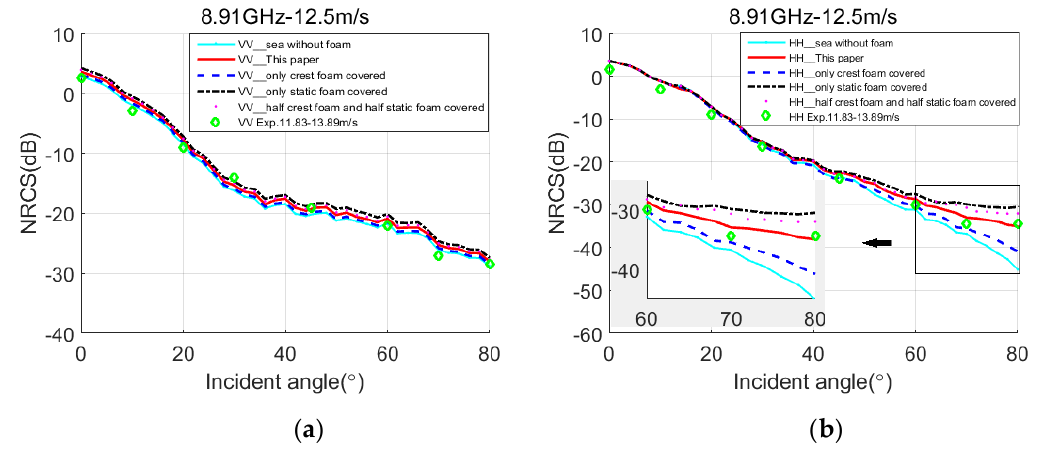
Figure 10. Comparison results of NRCS by the proposed model, the sea surface covered with crest foam only, the sea surface covered with static foam only, the sea surface covered half crest foam and half static foam and the measured data from JOSS-I model. f = 8.91 GHz, U 10 = 12.5 m / s. ( a ) VV polarization. ( b ) HH polarization.